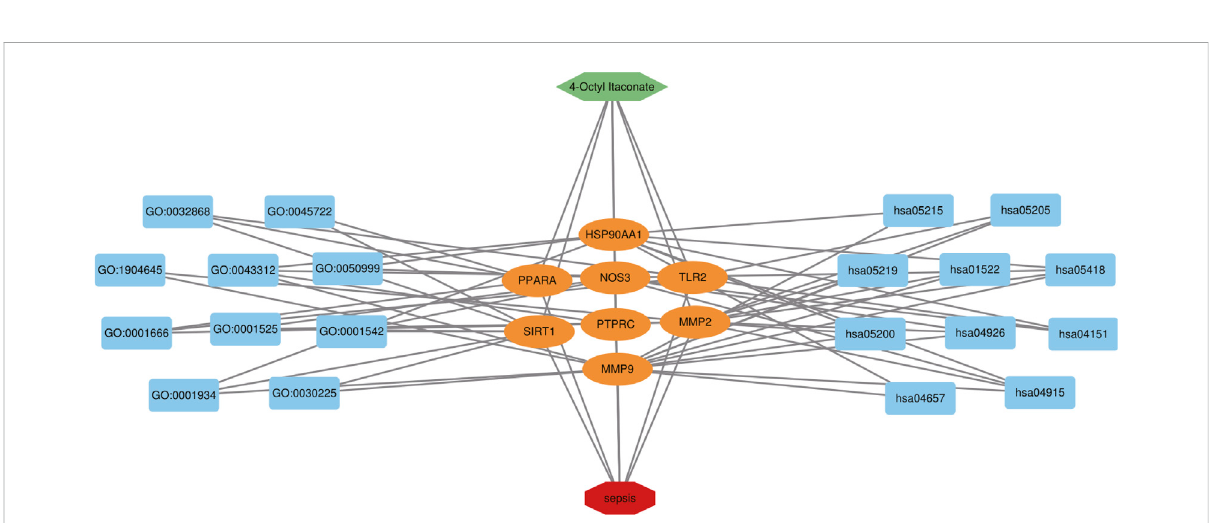
FIGURE 7 4-OI-target-sepsis detailed interaction network diagram. The dark blue rectangle on the left represents the fi rst ten biological processes of the antiseptic effect of 4-OI. The dark blue rectangle on the right represents the fi rst 10 KEGG signaling pathways of the 4-OI antiseptic effect. The orange oval in the middle represents the antiseptic target of